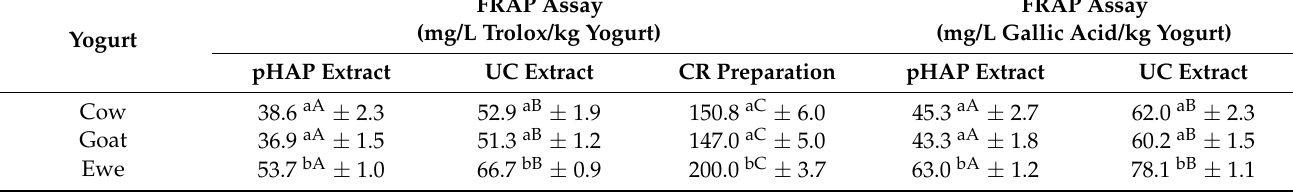
Table 4. Antioxidant activities of cow, goat and ewe yogurt preparations obtained by pH adjustment and precipitation (pHAP), ultra-centrifugation (UC), and “Clarifying Reagent” (CR), as determined by FRAP assay 1